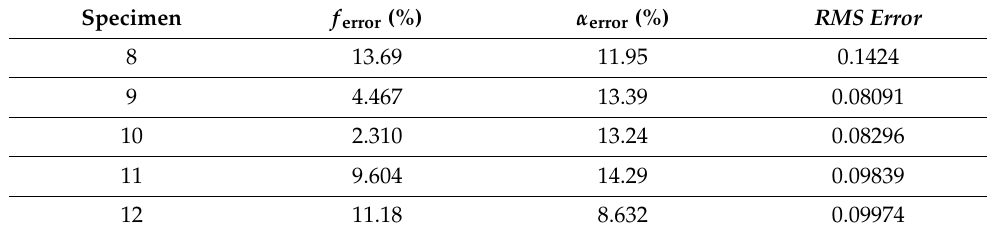
Figure 7. Comparison of the measured and predicted values of the normal incidence sound absorption coefficient of test specimen 8. The orange solid line represents the measured values, and the blue dotted line represents the predicted values. Table 4. Mean values of the error indices (Equations (4)–(6)) for the four conditions of air-back cavity depth of specimens 8–12.